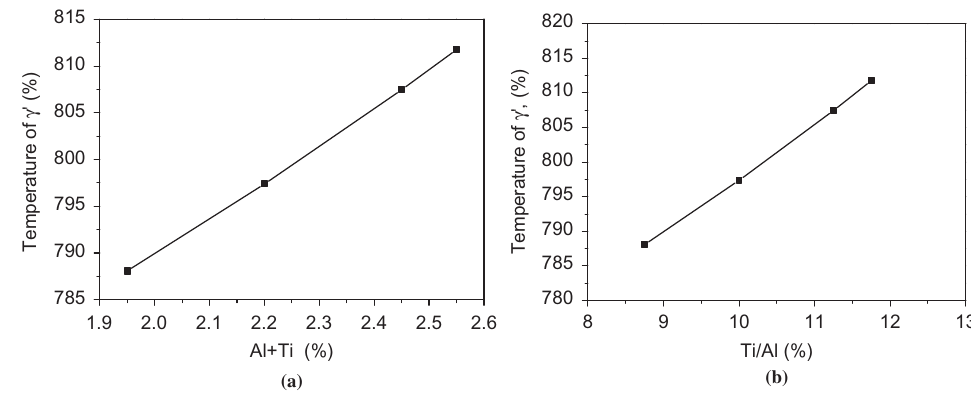
Figure 11: Influence of Al + Ti contents (a) and Ti/Al ratio (b) on solution temperature of γ ′ phase.